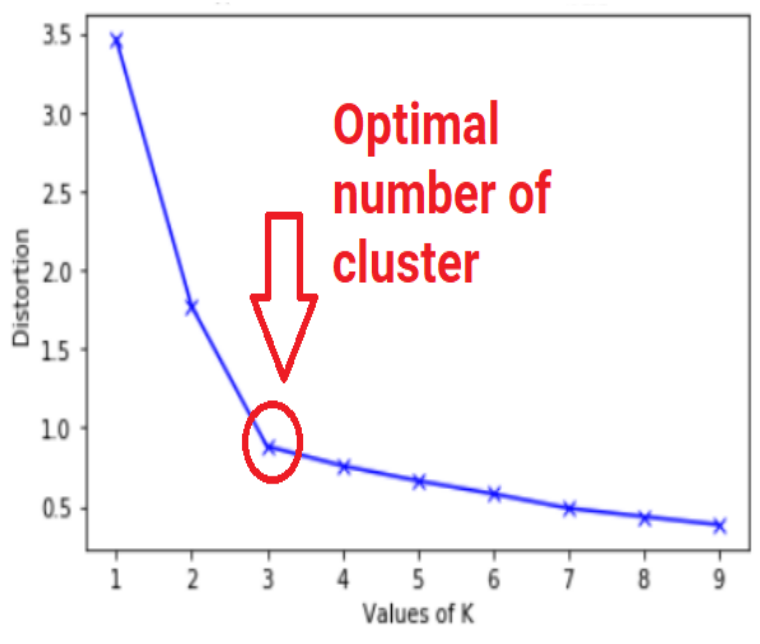
Figure 7. The elbow line chart using